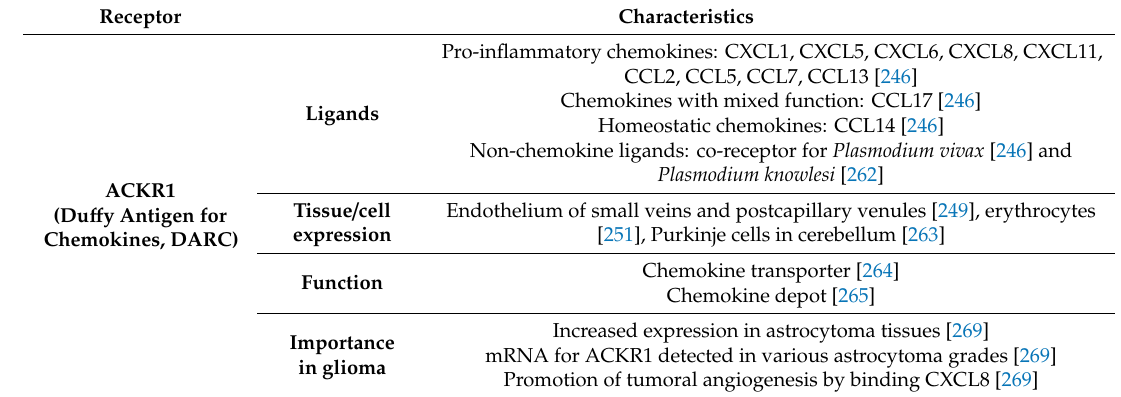
Table 2. Tissue distribution, biological functions, and ligand specificity of atypical receptors for chemokines